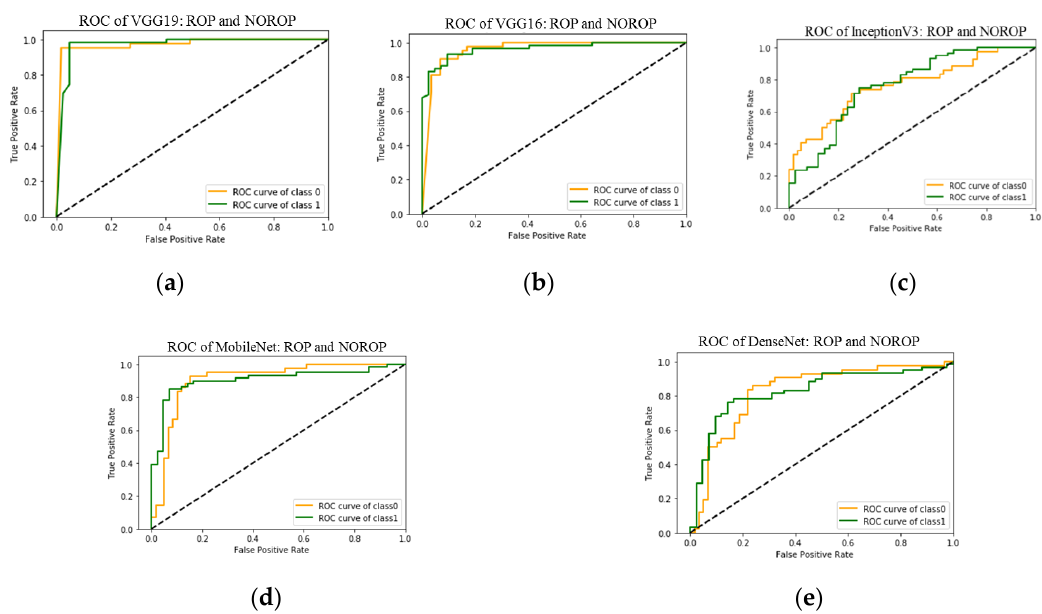
Figure 6. Receiver operating characteristics (ROC) curves of the DNN classification models. ( a ) VGG19, ( b ) VGG16, ( c ) InceptionV3, ( d ) MobileNet and ( e ) DenseNet. The orange and green ROC curves in the individual plots represent Class 0 (NOROP) and Class 1 (ROP), respectively.